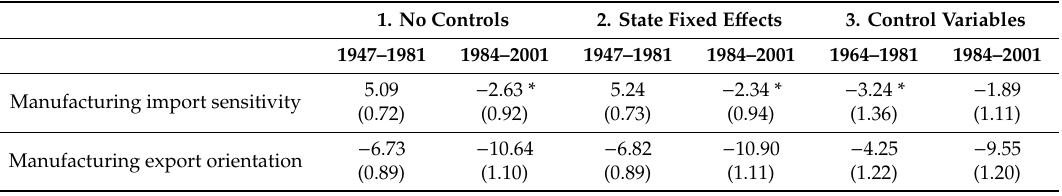
Table 1. Time-Series Cross-Sectional Count Models of Work Stoppages in U.S. States. 1. No